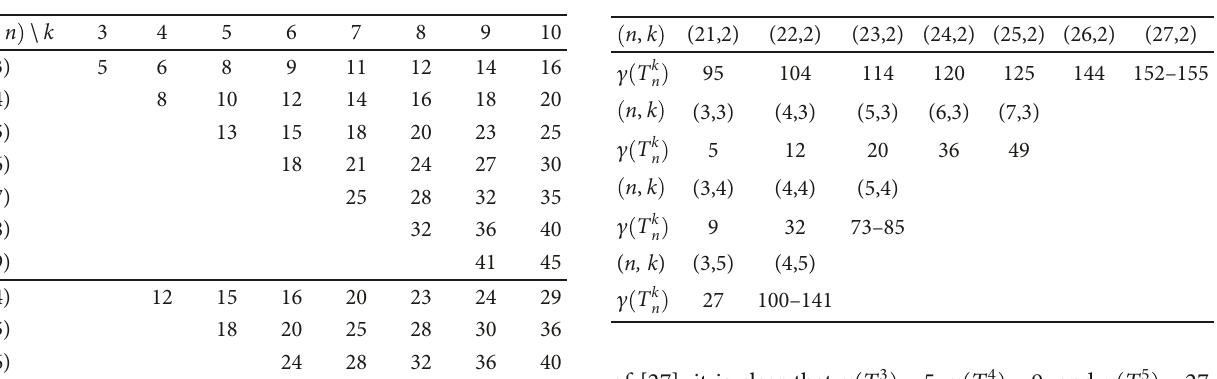
Table 5: Exact values of some 3D torus T